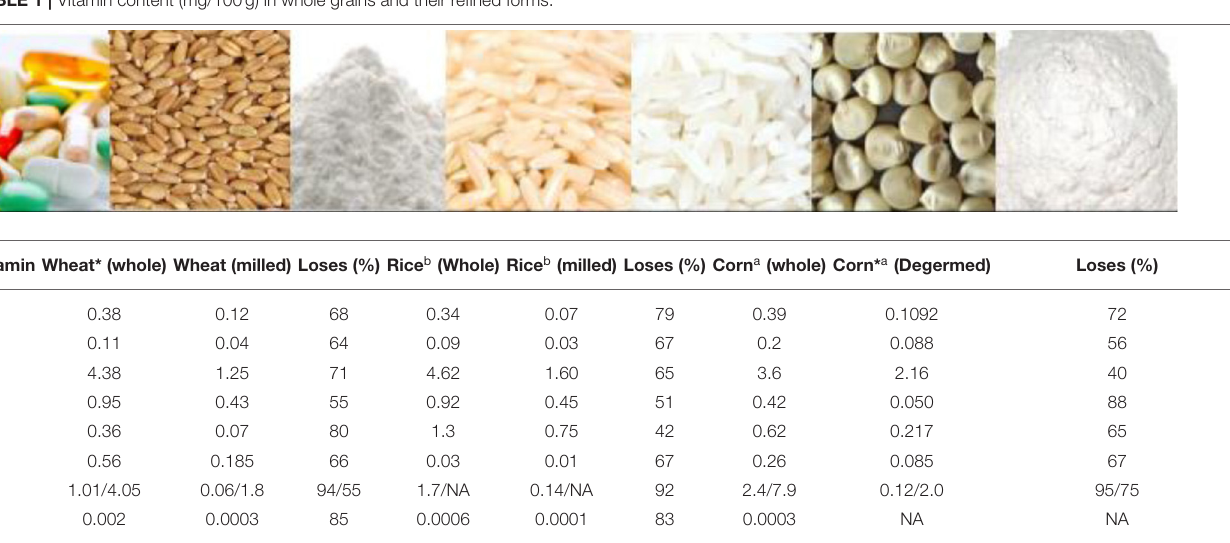
TABLE 1 | Vitamin content (mg/100g) in whole grains and their refined